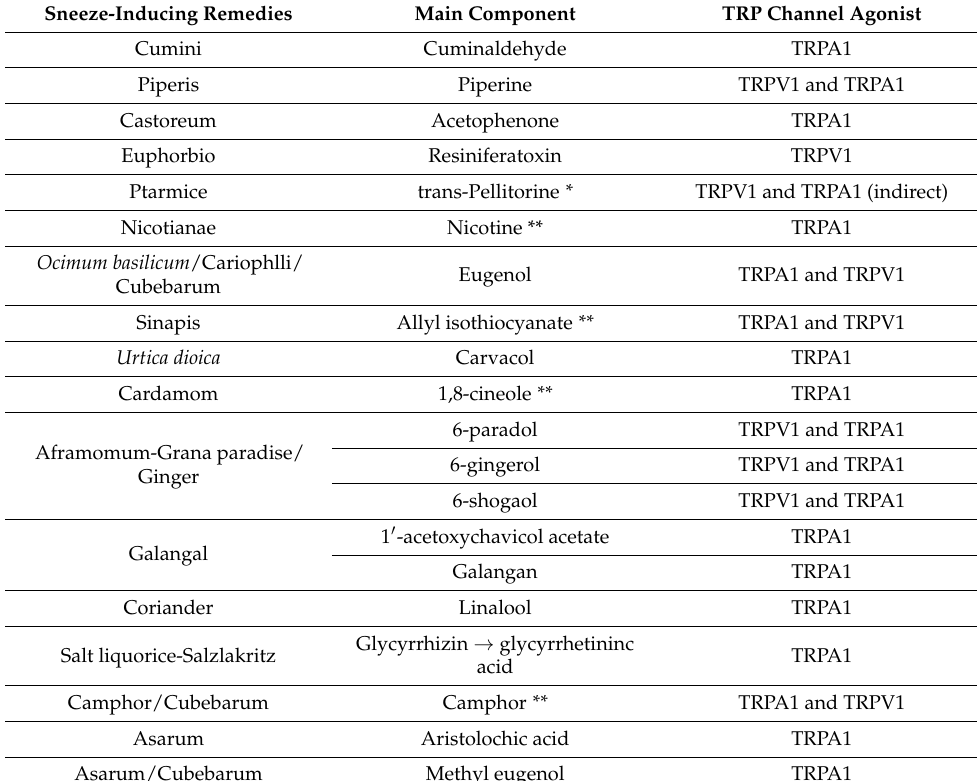
Table 2. The constituents of sneeze-inducing remedies and their TRP modulatory activity. Sneeze-Inducing